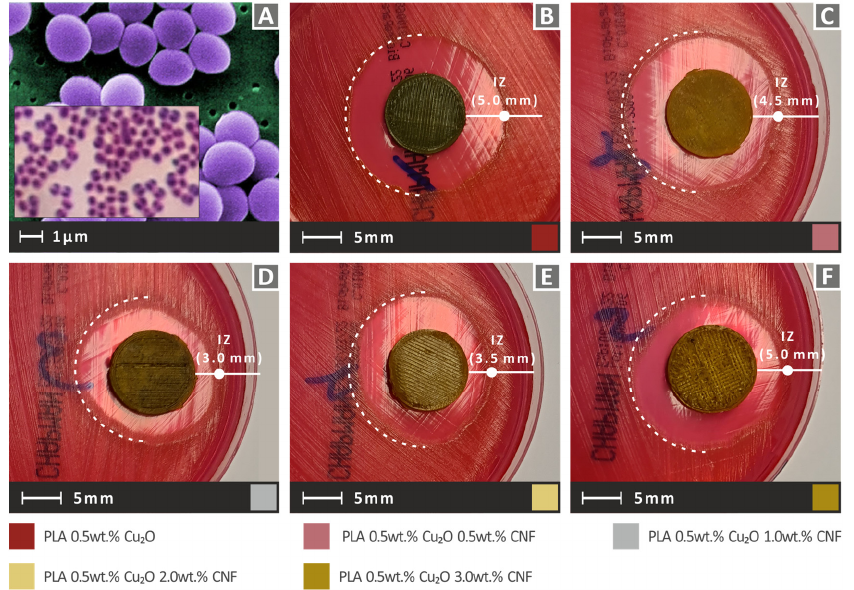
Figure 17. Antibacterial screening process for nanocomposites performance against S. aureus bacterium: ( A ) typical E. S. aureus morphology, ( B ) 0.5 wt.% Cu 2 O, ( C ) 0.5 wt.% Cu 2 O, 0.5 wt.% CNF, ( D ) 0.5 wt.% Cu 2 O, 1.0 wt.% CNF, ( E ) 0.5 wt.% Cu 2 O, 2.0 wt.% CNF, and ( F ) 0.5 wt.% Cu 2 O, 3.0 wt.%